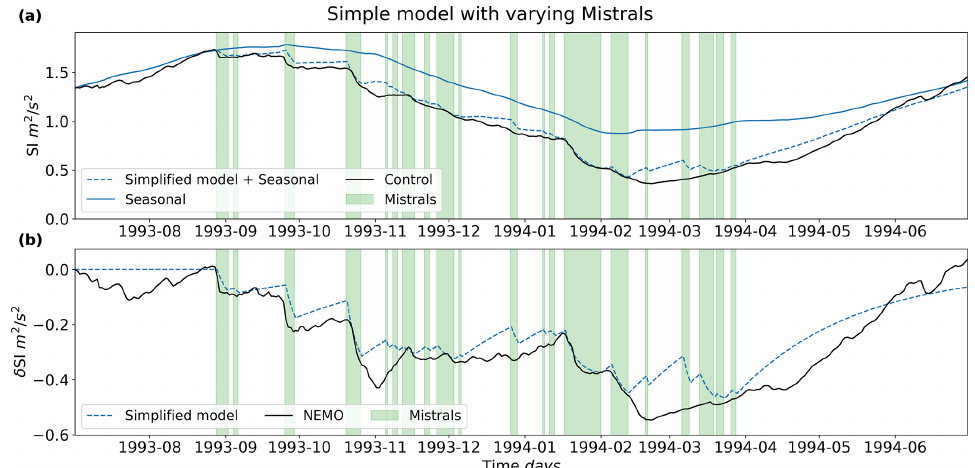
Figure 15. The stratification index for the 1994 winter for both the control and seasonal runs are shown in (a) and are spatially averaged over the area of 42 to 42.5 ◦ N and 4.25 to 5 ◦ E. The simplified model anomaly solution added to the seasonal SI is denoted by the dashed line. Panel (b) shows the NEMO-determined δ SI and the δ SI calculated from the anomaly solution of the simple model.